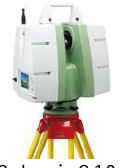
Figure 2. Lecia C10 scanner